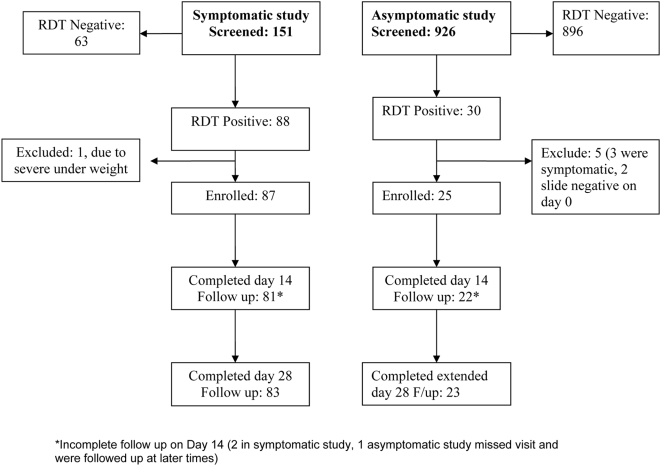
Trial profiles.*Incomplete follow up on Day 14 (2 in symptomatic study, 1 asymptomatic study missed visit and were followed up at later times).